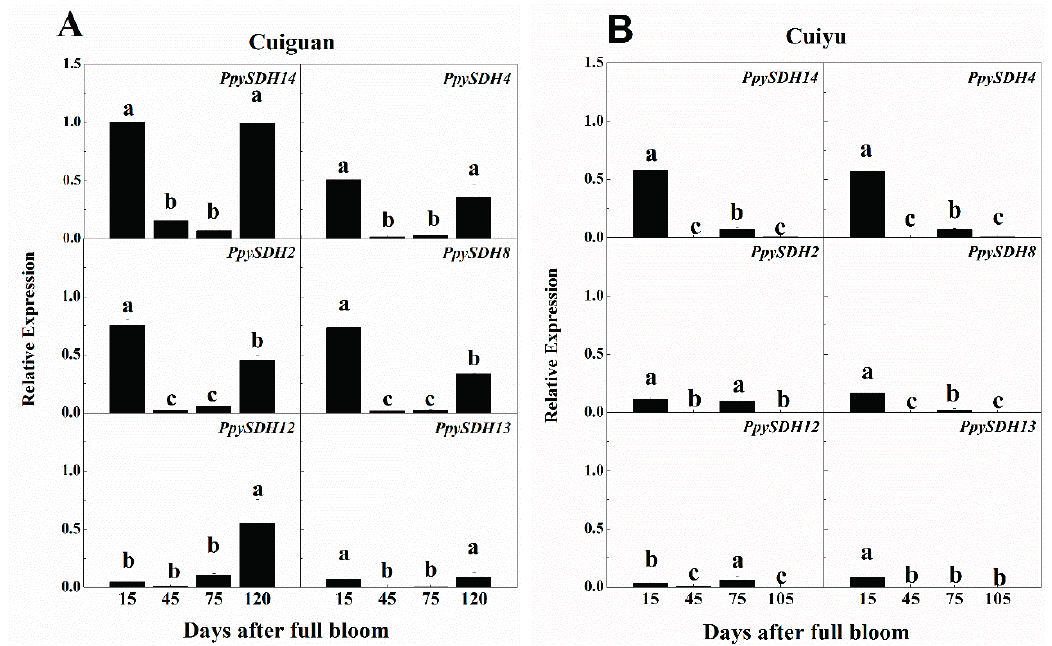
Figure 4. Relative expression levels of six selected PpySDH genes during fruit development of “Cuiguan” ( A ) and “Cuiyu” ( B ). The expression of each gene was normalized against 18S rRNA (internal control) by using the 2 −Δ C t method, and then, that with the strongest expression, PpySDH14 of “Cuiguan” at 15 days after full bloom in this figure, served as a calibrator (1.0); the expression of the remaining genes, including all analyzed members from “Cuiyu”, were expressed as a multiple of the calibrator. Error bars indicate the standard error (SE) from three biological replicates. Different letters within each chart indicate means that are significantly different ( p ≤